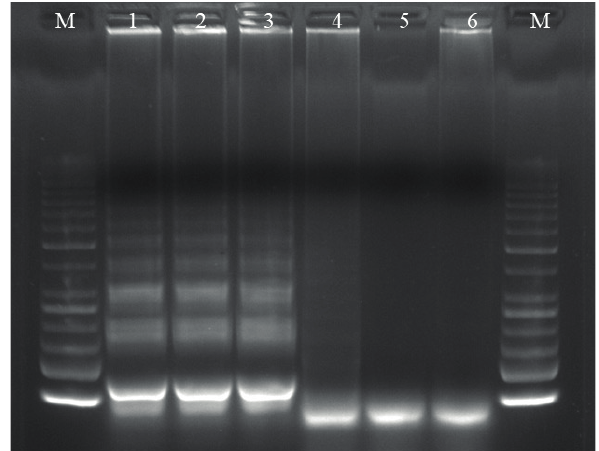
Figure 4. Detection of Pleurostoma richardsiae using the RealAmp products, which were electrophoresed in a 2% agarose gel and inspected under UV light. M: marker; 1, 2, and 3: Pl. richardsiae ; 4: Pl. repens ; 5: Pl. ootheca ; 6: water control.